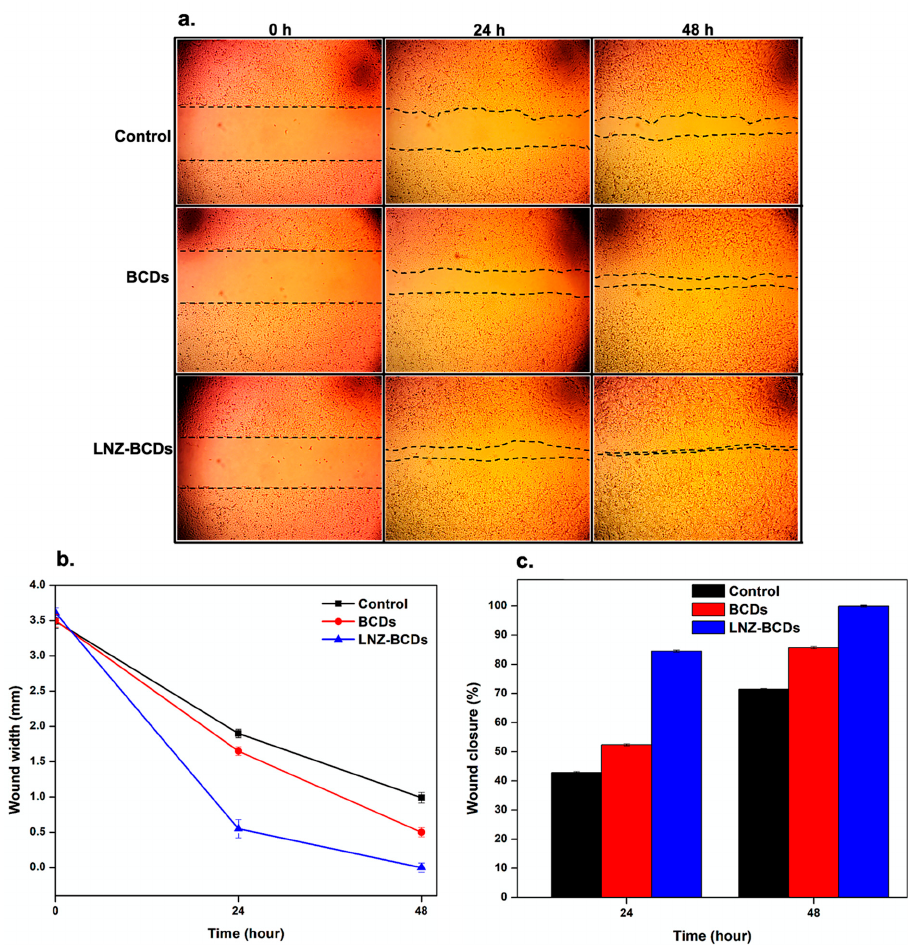
Figure 11. ( a ) Images at 1 mm scale bar, ( b ) profile of changes in the width of wounds with time, and ( c ) wound closure percentages of untreated control and treated normal human skin fibroblast (HSF) cell line with BCDs nano-biocarrier and LNZ–BCDs nano-bioconjugate at 24 and 48 h.